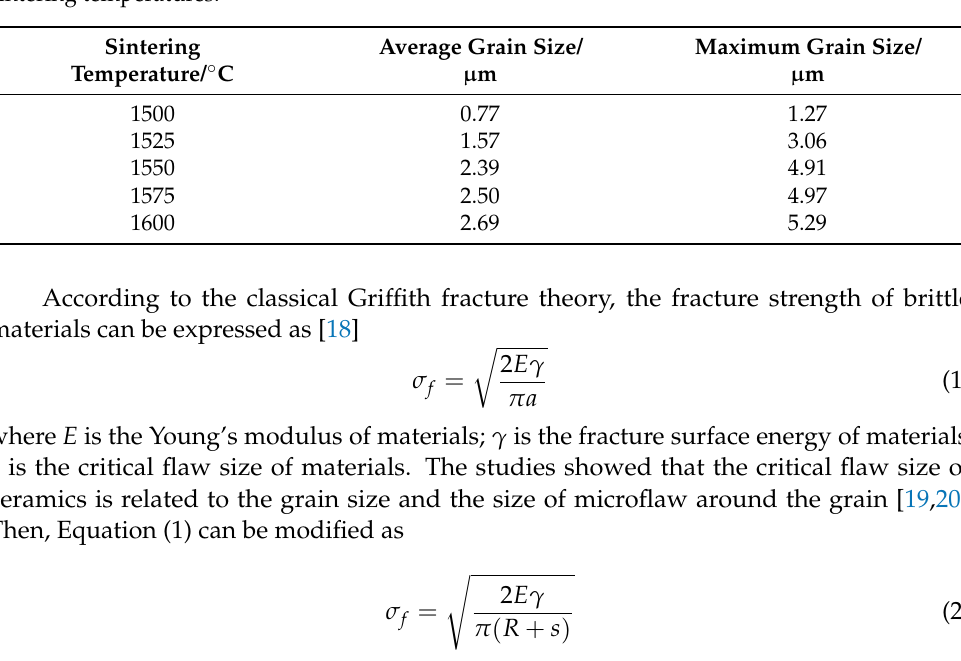
Table 2. The average grain size and maximum grain size of Al 2 O 3 -G-M hot-pressed at different sintering